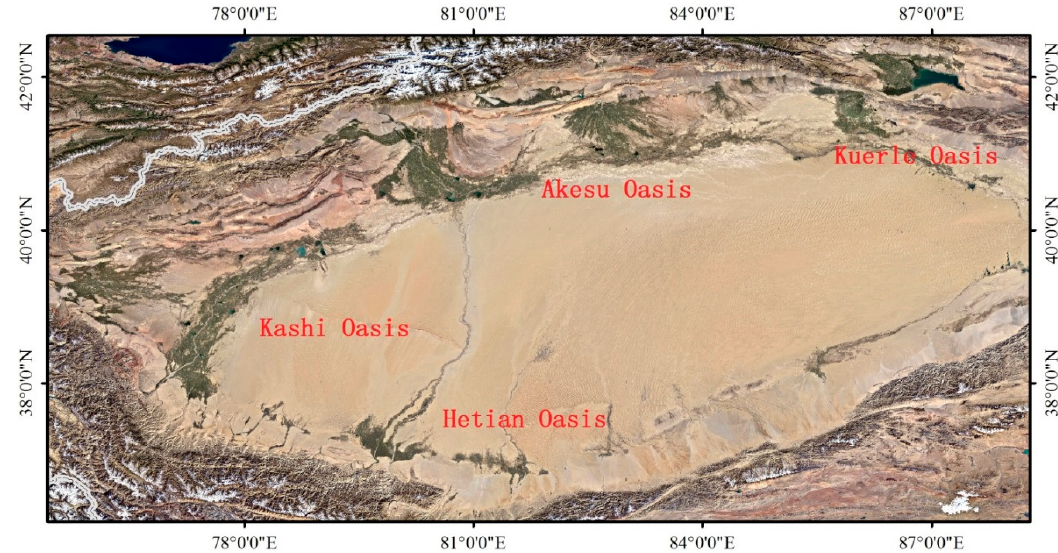
Figure 1. Spatial distribution of oasis in Tarim Basin, obtained from Google Earth. The linkage for